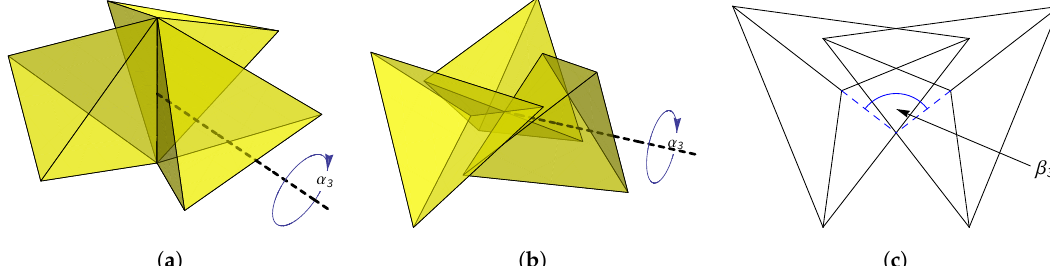
Figure 2. Arranging and rotating three tetrahedra (as done in the n = 5 case) to “close up” gaps between adjacent tetrahedra. When this operation is performed, the angle β 3 = 2 π projection of a “face junction”. ( a ) Three tetrahedra arranged about a common edge. In this arrangement, large gaps exist between the faces of adjacent tetrahedra. Each tetrahedron is to be rotated by α 3 about an axis passing between the midpoints of its central and peripheral edges. ( b ) The tetrahedra after rotation. In this arrangement, the faces of adjacent tetrahedra have been brought into contact with one another. ( c ) A projection of a “face junction” between two coincident faces in Figure 2b. The angular displacement between the faces is β 3